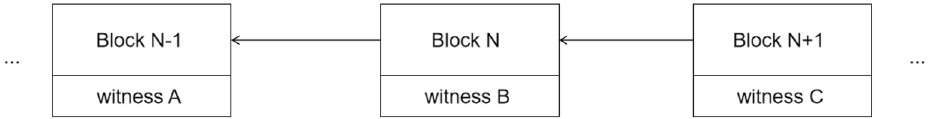
Figure 2. Witness nodes generate block in turn, and every witness node generates one block in one round.